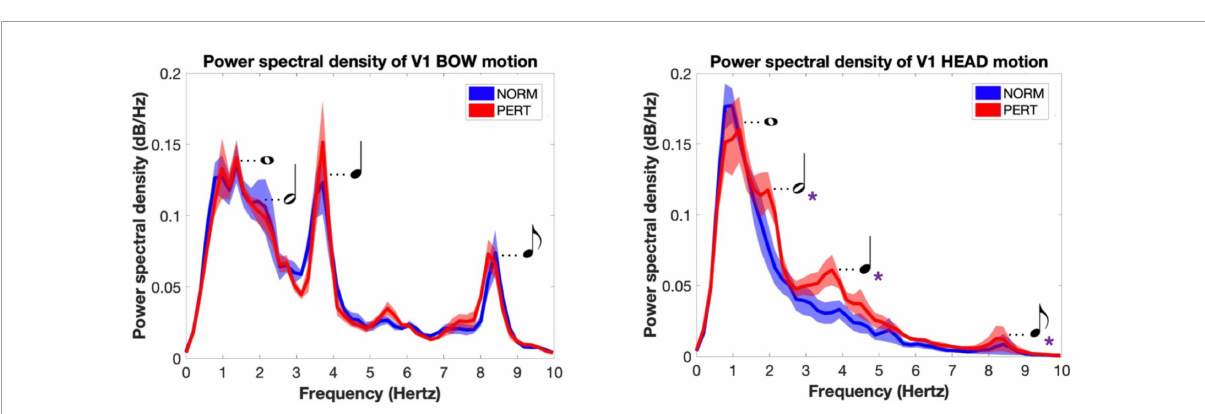
FIGURE5 Power spectral density of V1’s bow (Left) and head (Right) motions for each experimental condition. Main frequency peaks are associated with the rhythmical values they corresponded to in the performed piece (and represented here as musical notations). Bow motion was characterized by multiple periodicities that reflected the metrical organization of the score. Head motion shift from simple patterns dominated by one frequency peak near 1 Hz in NORM to more complex patterns of motion in PERT, where multiple, faster periodicities appeared and matched those found in the bow motion. Shaded areas represent standard errors of the mean; violet asterisks denote the metrical scales where power was significantly different across